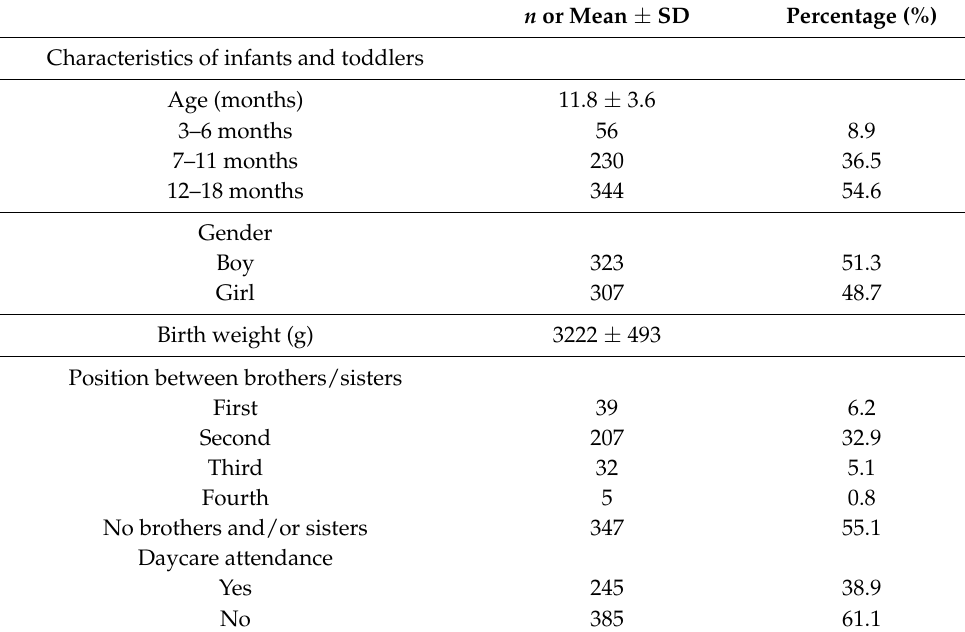
n or Mean ± SD Percentage (%)